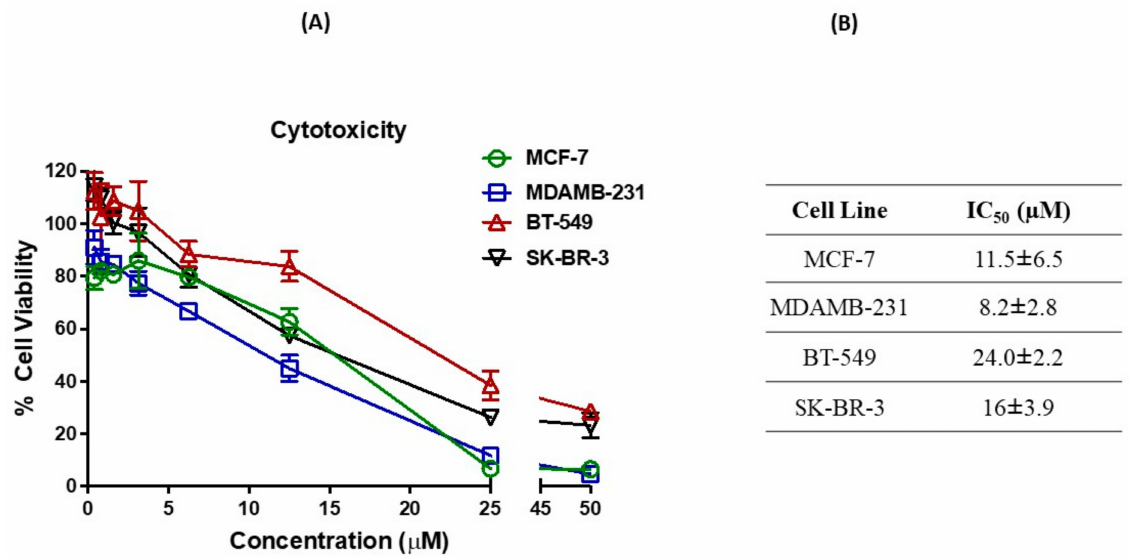
Figure 1. ( A ) Inhibitory effects on different breast cancer cell lines (MCF-7, MDAMB-231, BT-549 and SK-BR-3) after treatments with AQ. ( B ) IC 50 of AQ in MCF-7, MDAMB-231, BT-549 and SK-BR-3. Data represent mean ± SD ( n = 6) of at least 3 independent